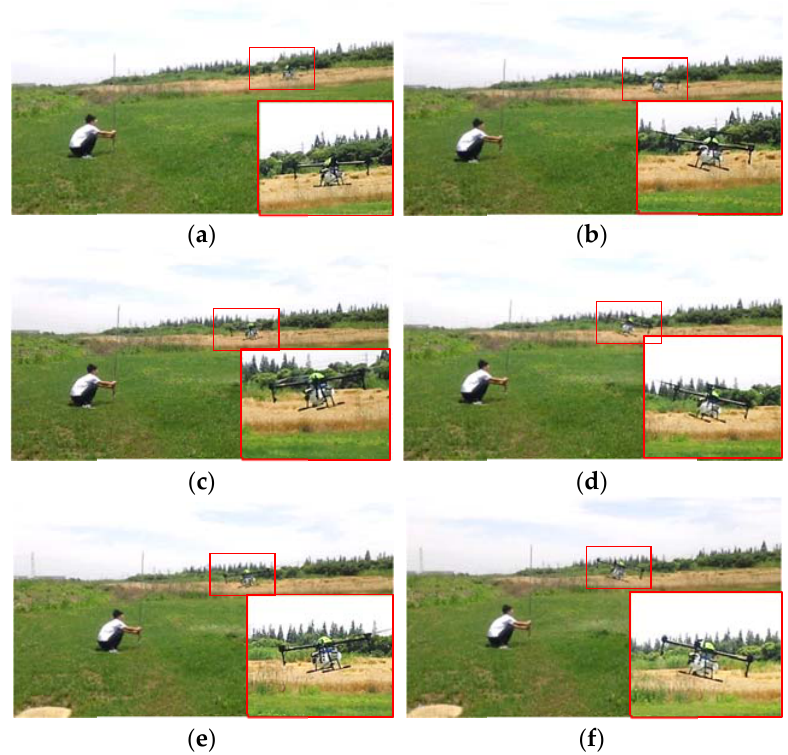
Figure 1. Sequences of UAV’s attitude caused by liquid slosh while facing an obstacle. ( a ) The first moment of detection, ( b ) negative pitch for initial breaking process, ( c ) rapid positive pitch because backward slosh force made the pitch unstable, ( d ) rapid negative pitch because forward slosh force made the pitch unstable again, ( e ) effect similar to c, ( f ) and effect similar to ( d